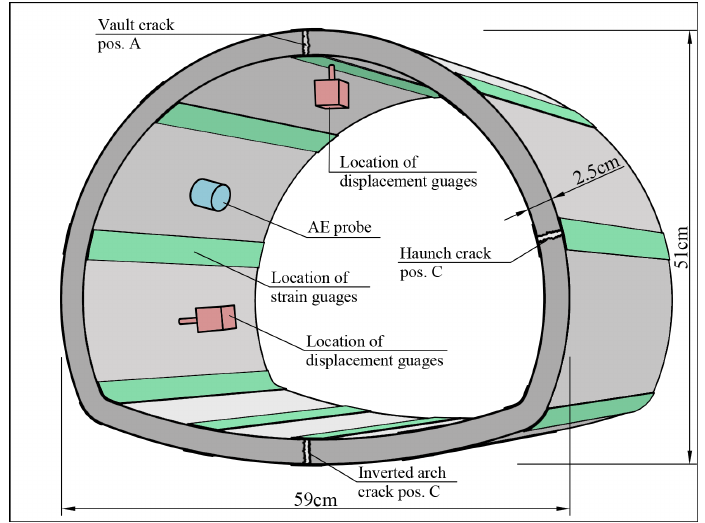
Figure 4. Experimental set-up and location of existing cracks in testing performed by Su et al.